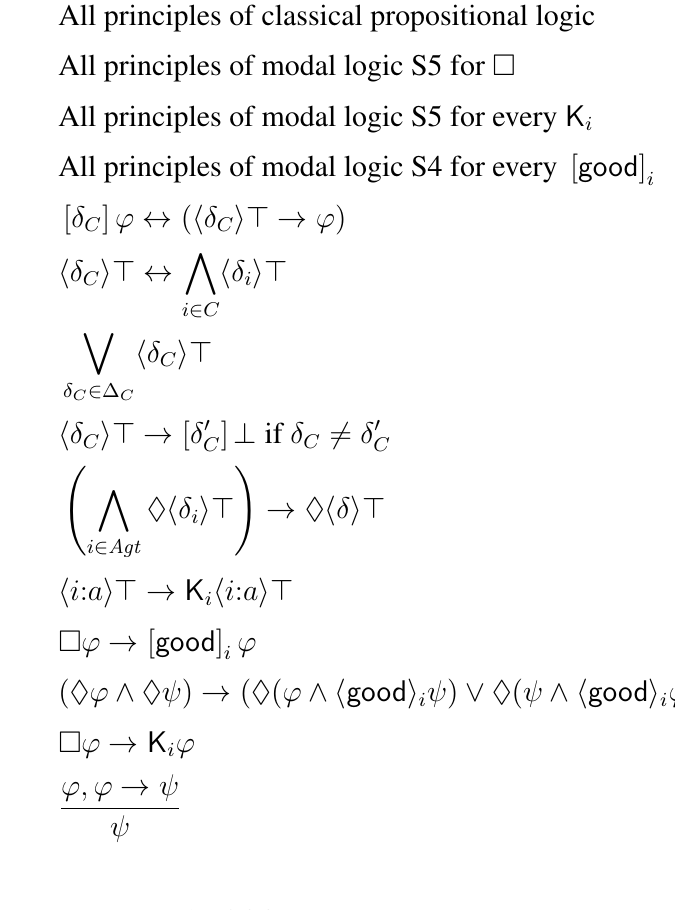
Figure 2. Axiomatization of MLEG